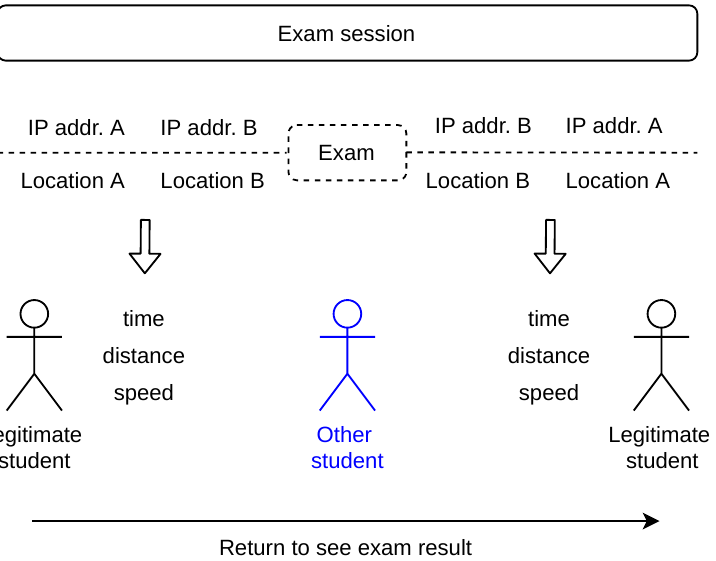
Figure 8. Indication events during exam session. The case of two student’s role changes is